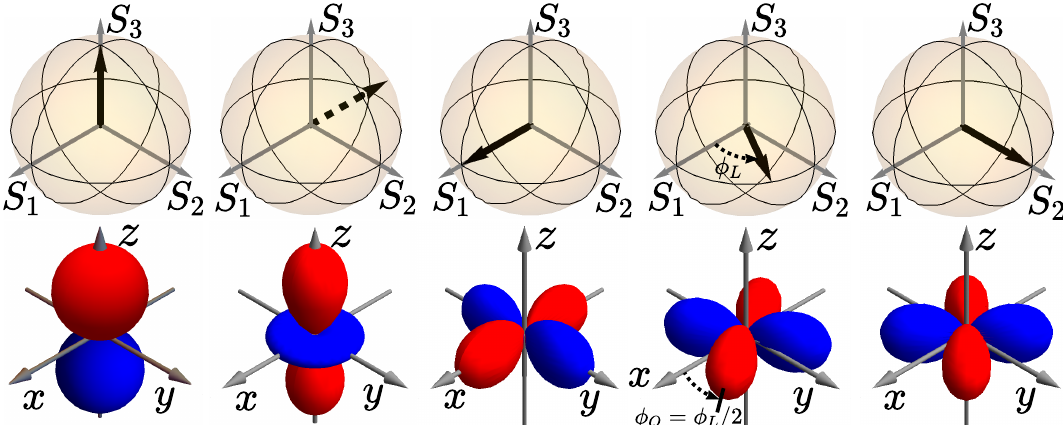
Figure 8. Polarization states on Poincaré sphere ( upper row ) and illustrations of magnetic states ( lower row ) coupling to them. Red denotes south pole, blue north pole (for positive irreducible components). Leftmost column: A light beam with helicity, i.e., non-zero S 3 (out of the equatorial plane), will generate a magnetic dipole corresponding to an orientation w . The second left column illustrate a magnetic quadrupole with principle axis aligned to the z -axis corresponding to a longitudinal alignment X . It is driven by the total intensity S 0 independent of the polarization state. The remaining three columns illustrate quadrupoles in the x - y -plane driven by linearly polarized light in the equatorial plane of the Poincaré sphere. These correspond to the ∆ m = 2-coherence Φ in the atom representing a transverse alignment. Light polarized along the x -direction (centre column, pump polarization used in experiments) just drives the real part u of the coherence represented by a quadrupole with one (north) of the principal axes along the x -direction and the other along y . Light polarized at 45 ◦ drives the imaginary part v with the north principal axis oriented at 45 ◦ . In general, light with a phase φ L between σ components (second to right column) drives a quadrupole with north principle axis at the polarization angle φ Q = φ p = φ L /2 (conventional optics notation, ( φ L − π ) /2 in convention used in our theoretical